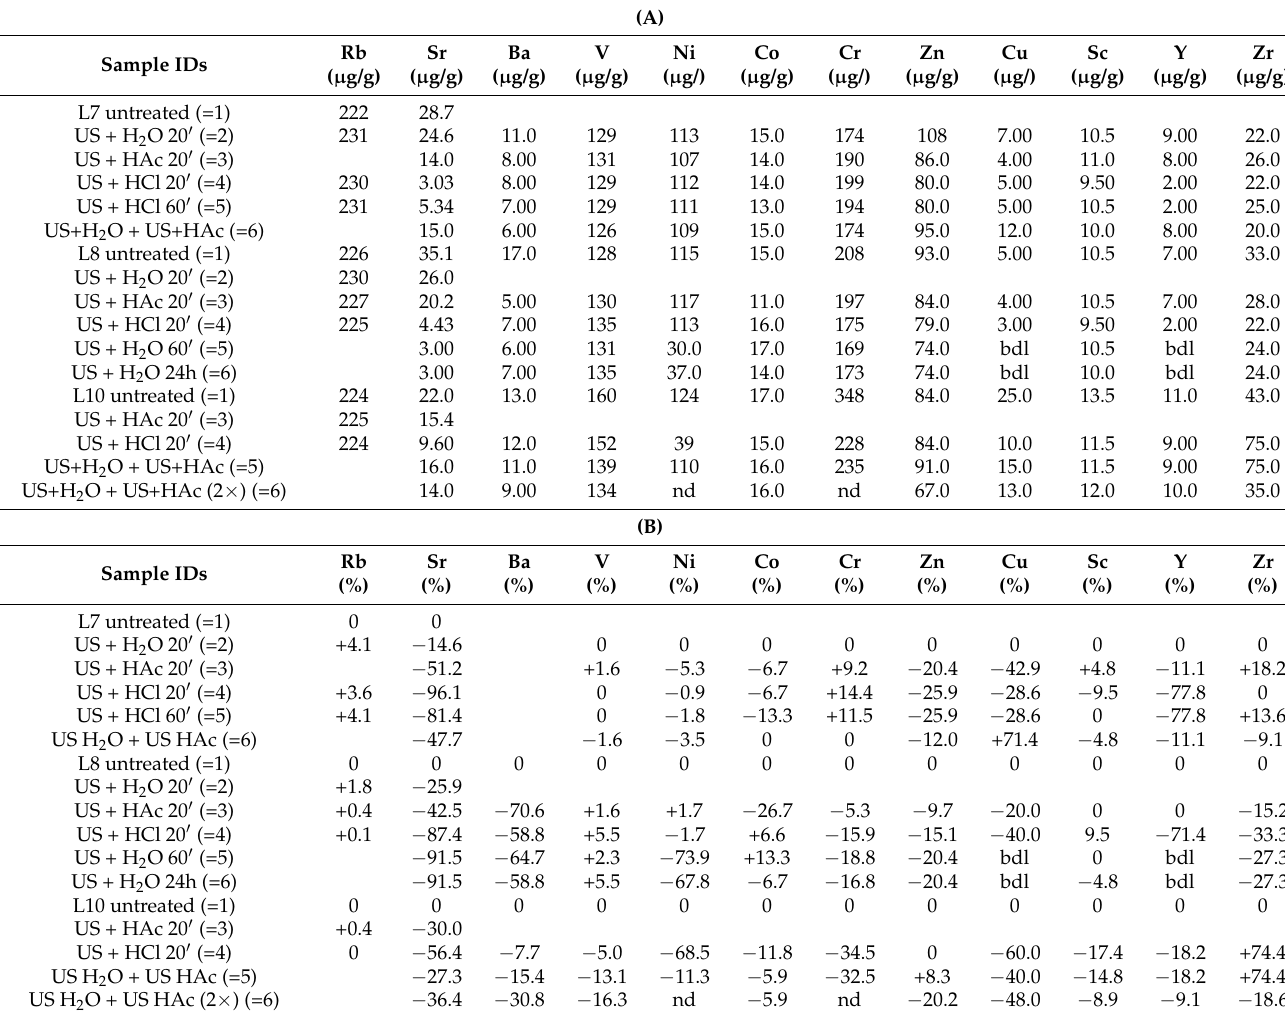
Table 2. (A) Contents in trace elements of the untreated and leached glauconite pellets; (B) Variations in the contents in trace elements of the leached separates relative to the untreated reference